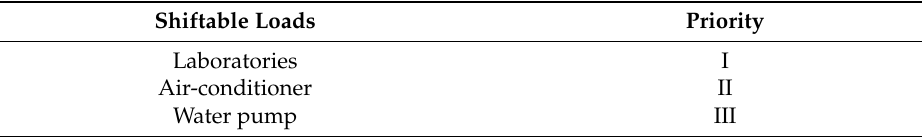
Table 3. End-user priority for shiftable loads.